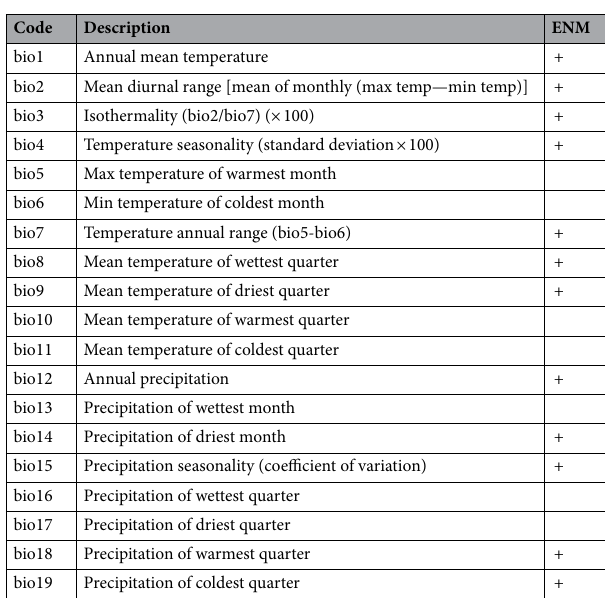
Table 1. Bioclimatic variables. Layers used in ENM analyses marked with ‘ + ”.